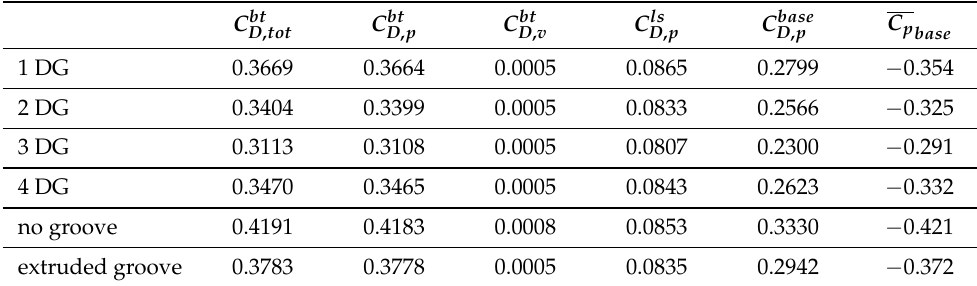
Table 1. Pressure and viscous contributions to drag coefficient and average base pressure coefficient compared to the boat-tail without and with spanwise-extruded grooves from [17].